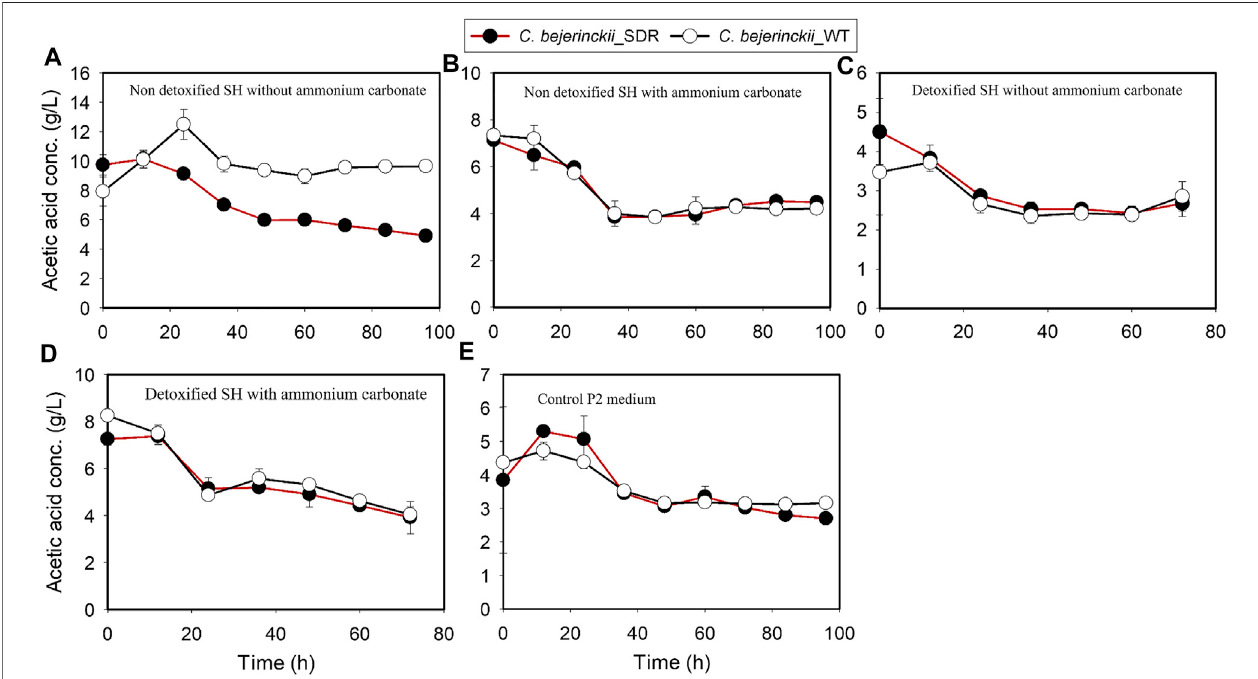
FIGURE 3 | Acetic acid concentration pro fi les in the fermentation media using C. beijerinckii _SDR or C. beijerinckii _wildtype. (A) Non-detoxi fi ed SH without ammonium carbonate. (B) Non-detoxi fi ed SH with ammonium carbonate. (C) Detoxi fi ed SH without ammonium carbonate. (D) Detoxi fi ed SH with ammonium carbonate. (E) Control P2 medium.